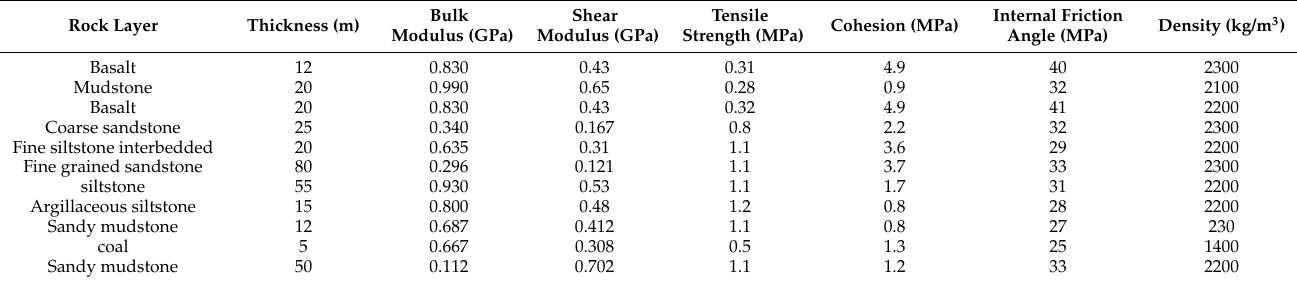
Figure 3. Numerical model. (Different colors in the model represent different strata, and the order from top to bottom is shown in Table 1). Table 1. Mechanical parameters of rock strata.